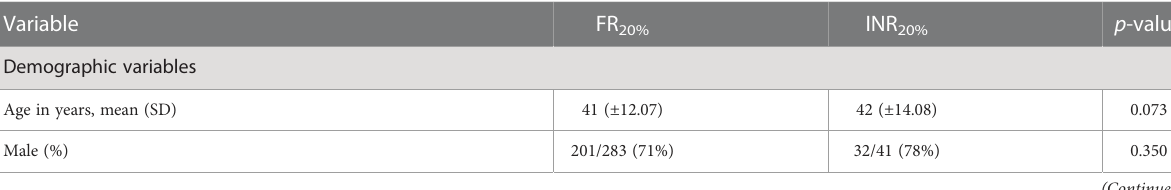
TABLE 2 Comparison of clinical and demographic characteristics of INR 20% and full responders